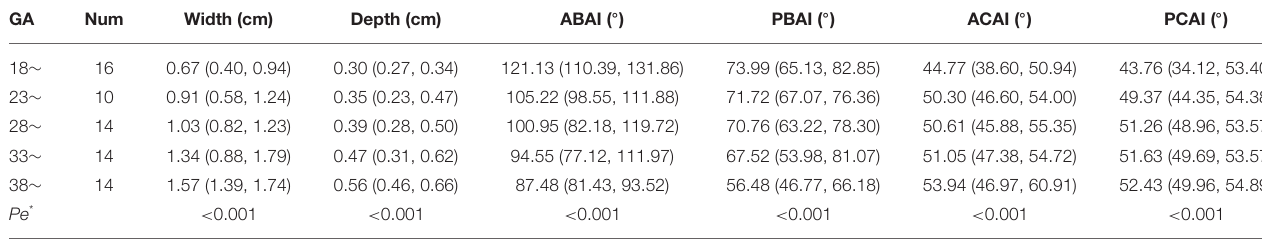
TABLE 1 | Six indicators of femoral head coverage grouped by gestational